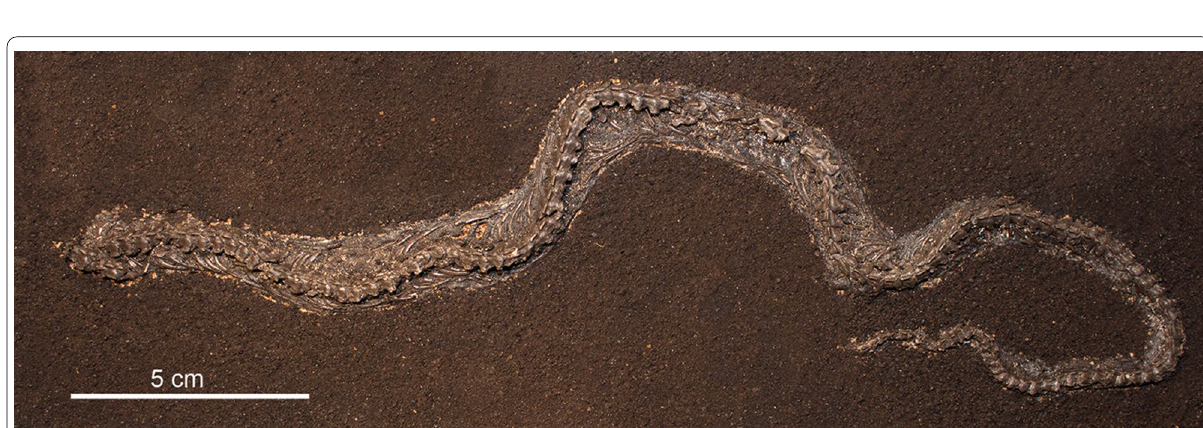
ventral view (Figs. 18d, 19f), the haemal keel grew rela- tively sharp by mid-length. Relatively sharp subcentral ridges give the centrum a triangular shape. A rather small subcentral foramen is present on the right side of the hae- mal keel (the left side is unknown). The paradiapophyses are massive and elliptical. In lateral view (Figs. 18e, f, 19g, h), the vertebra is taller than long. The zygosphe- nal articular facets are massive. Lateral foramina are present just posterior to the diapophysis and below the